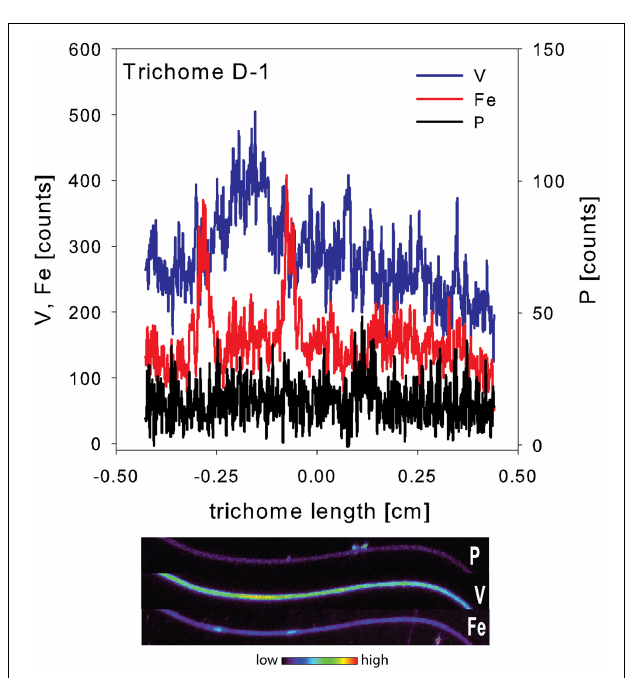
FIGURE 12 | One dimensional line plot along the main axis of trichome D-1. Data were extracted from the entire visible section of the trichome mapped here. Associated elemental maps of P,V, and Fe are given below.